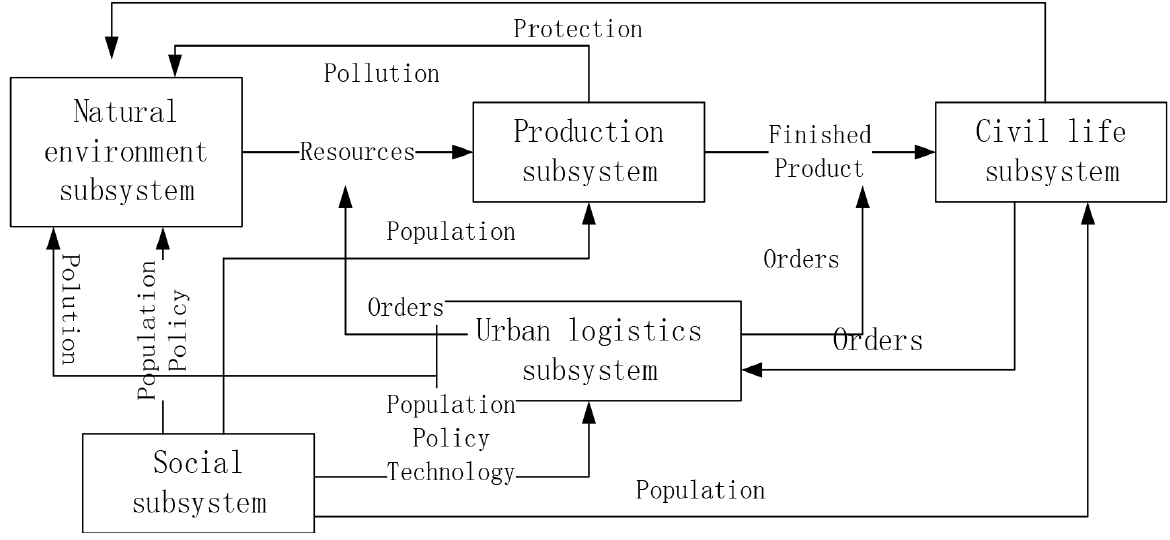
Figure 2. Boundary and structure of SD model